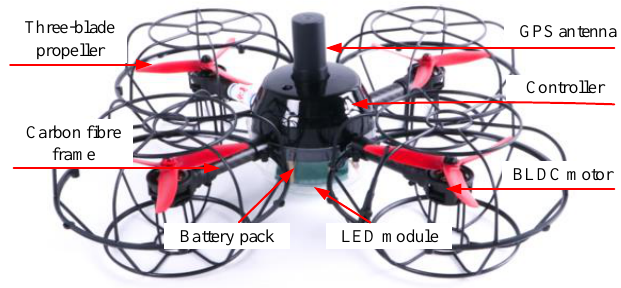
Figure 8. Prototype of the quadrotor developed for the UAV-LS